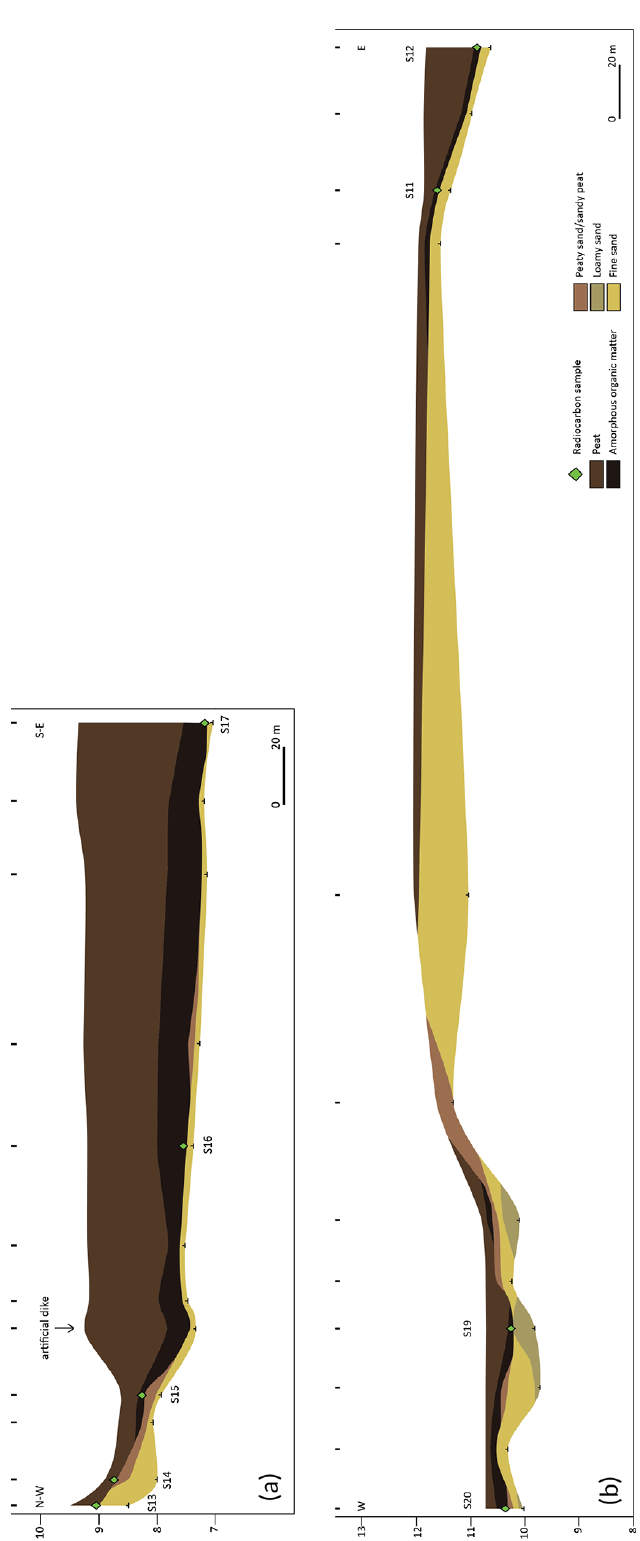
Figure 4. Two cross sections showing example transects perpendicular to cover sand ridges underlying the organic deposits in the Fochteloërveen peat remnant. See Fig. 2 for location of the transects; (a) transect covering one side of a ridge; (b) transect covering both sides of a ridge. Corings are indicated with vertical bars at the top of each cross section. The numbers (of the format Sxx) refer to the sampling site codes (see Tables 1 and